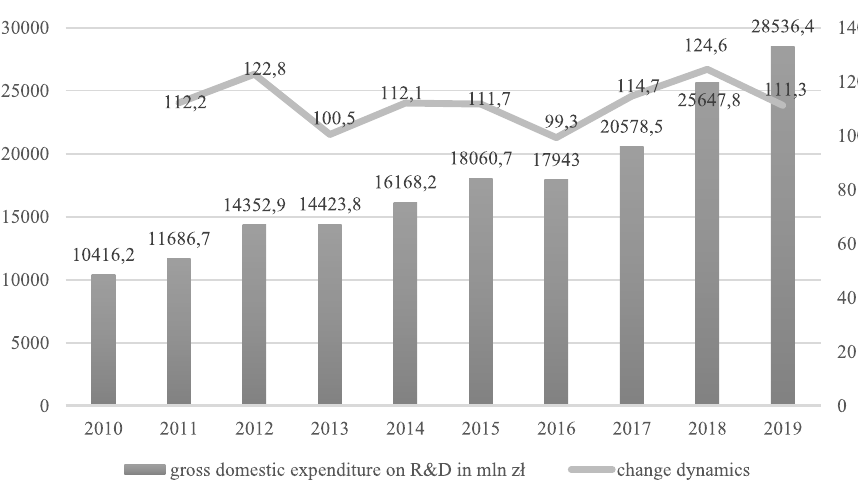
Figure 1. Gross domestic expenditure on R&D in PLN million and its dynamics (previous year = 100) in 2010–2019